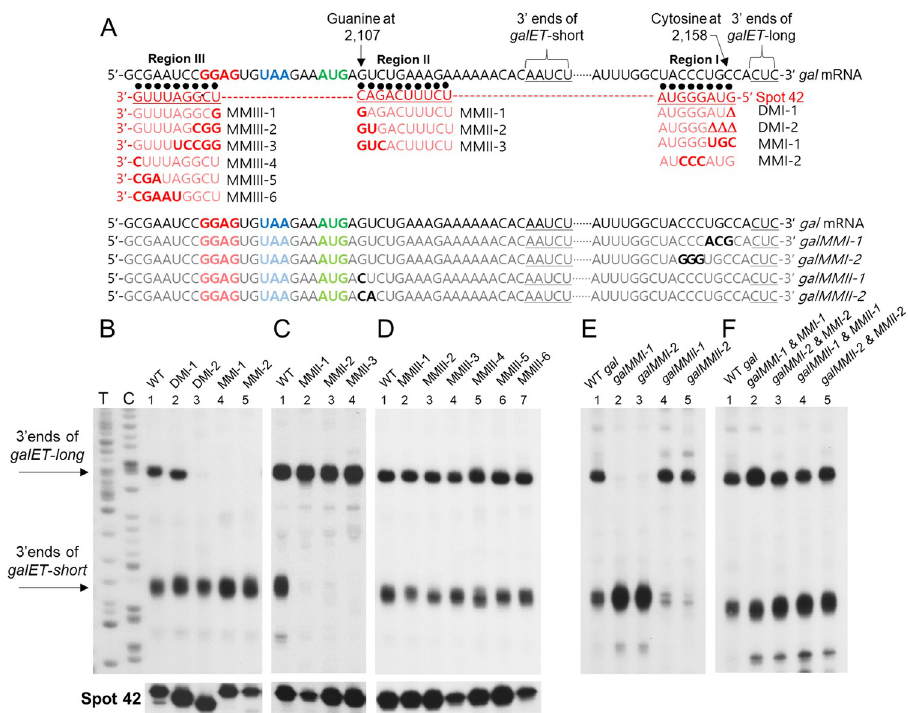
Fig 2. Specific base-pairing of Spot 42 and gal mRNA is critical for the generation of galET 3’ ends. A) The top two lines show the sequence stretches of Spot 42 Regions I-III that are complementary to gal mRNA as in Fig 1A. The 3’ end sequences of galET-short at 2,125–9 and galET-long at 2,161–3 are indicated by inverted braces as well as underlined. Guanine at 2,107 and Cytosine at 2,158 are indicated to help locate the mutated nucleotides shown in the lines that follow. The base changes are in bold. The upper lines show the changes in Spot 42 and lower lines the changes in gal mRNA. B) 3’ RACE assay of 3’ ends of galET RNA from MG1655 Δ spf cells carrying a plasmid-borne WT Spot 42 gene or its Region I mutant derivatives. Shown at the bottom are 5’ RACE assay to indicate the relative amounts of Spot 42 WT and mutant RNAs in different lanes. C) Same as (B) except that Spot 42 was mutated in Region II. D) Same as (B) except that Spot 42 was mutated in Region III. E) 3’ RACE assay of 3’ ends of galET RNA from MG1655 Δ gal carrying different plasmid-borne gal mutant operons. F) 3’ RACE assay of 3’ ends of galET RNA from MG1655 Δ gal Δ spf cells carrying two different plasmids, one with mutated gal operon and the other with mutated Spot 42 gene. The plasmid pairs were chosen so that their mutated bases are complementary to each other. The data presented in these blots are representative of three independent